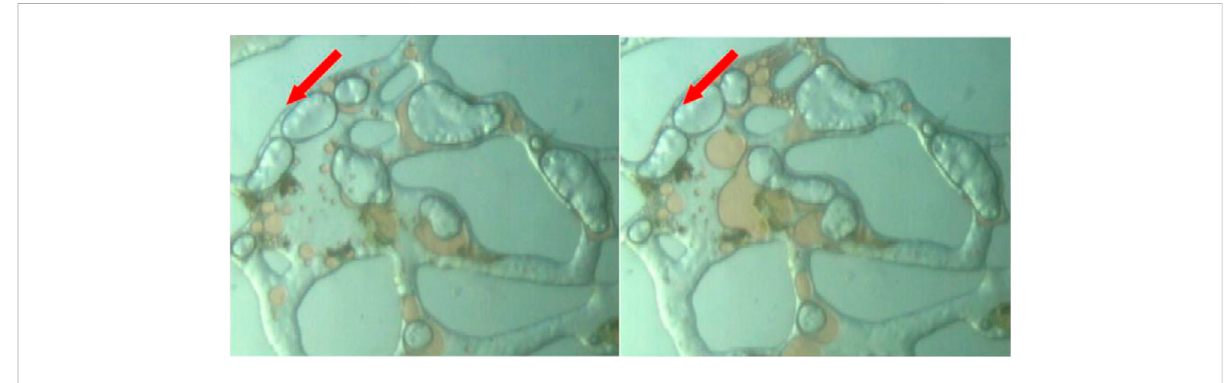
FIGURE 1 Preferential blocking action of foams (Li et al.,